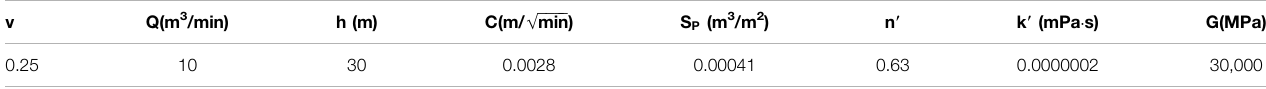
TABLE 4 | The input parameters for calculating the fracture